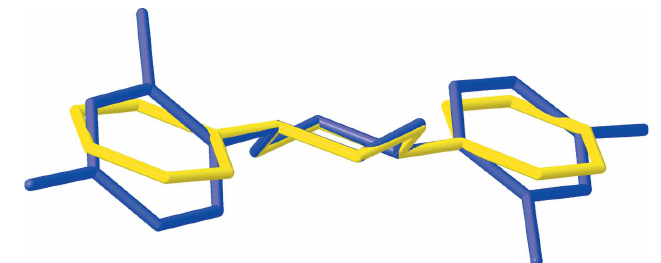
Figure 4 Type I bromine-bromine interaction in the packing of compound 1 . Carbon-bound hydrogen atoms are omitted for clarity.